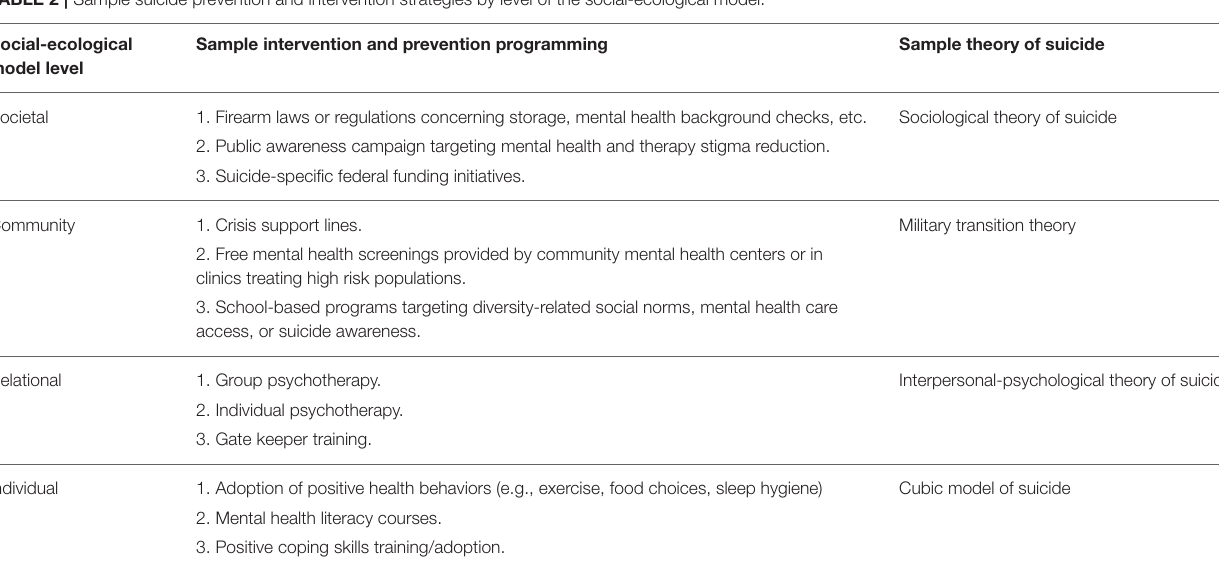
TABLE 2 | Sample suicide prevention and intervention strategies by level of the social-ecological